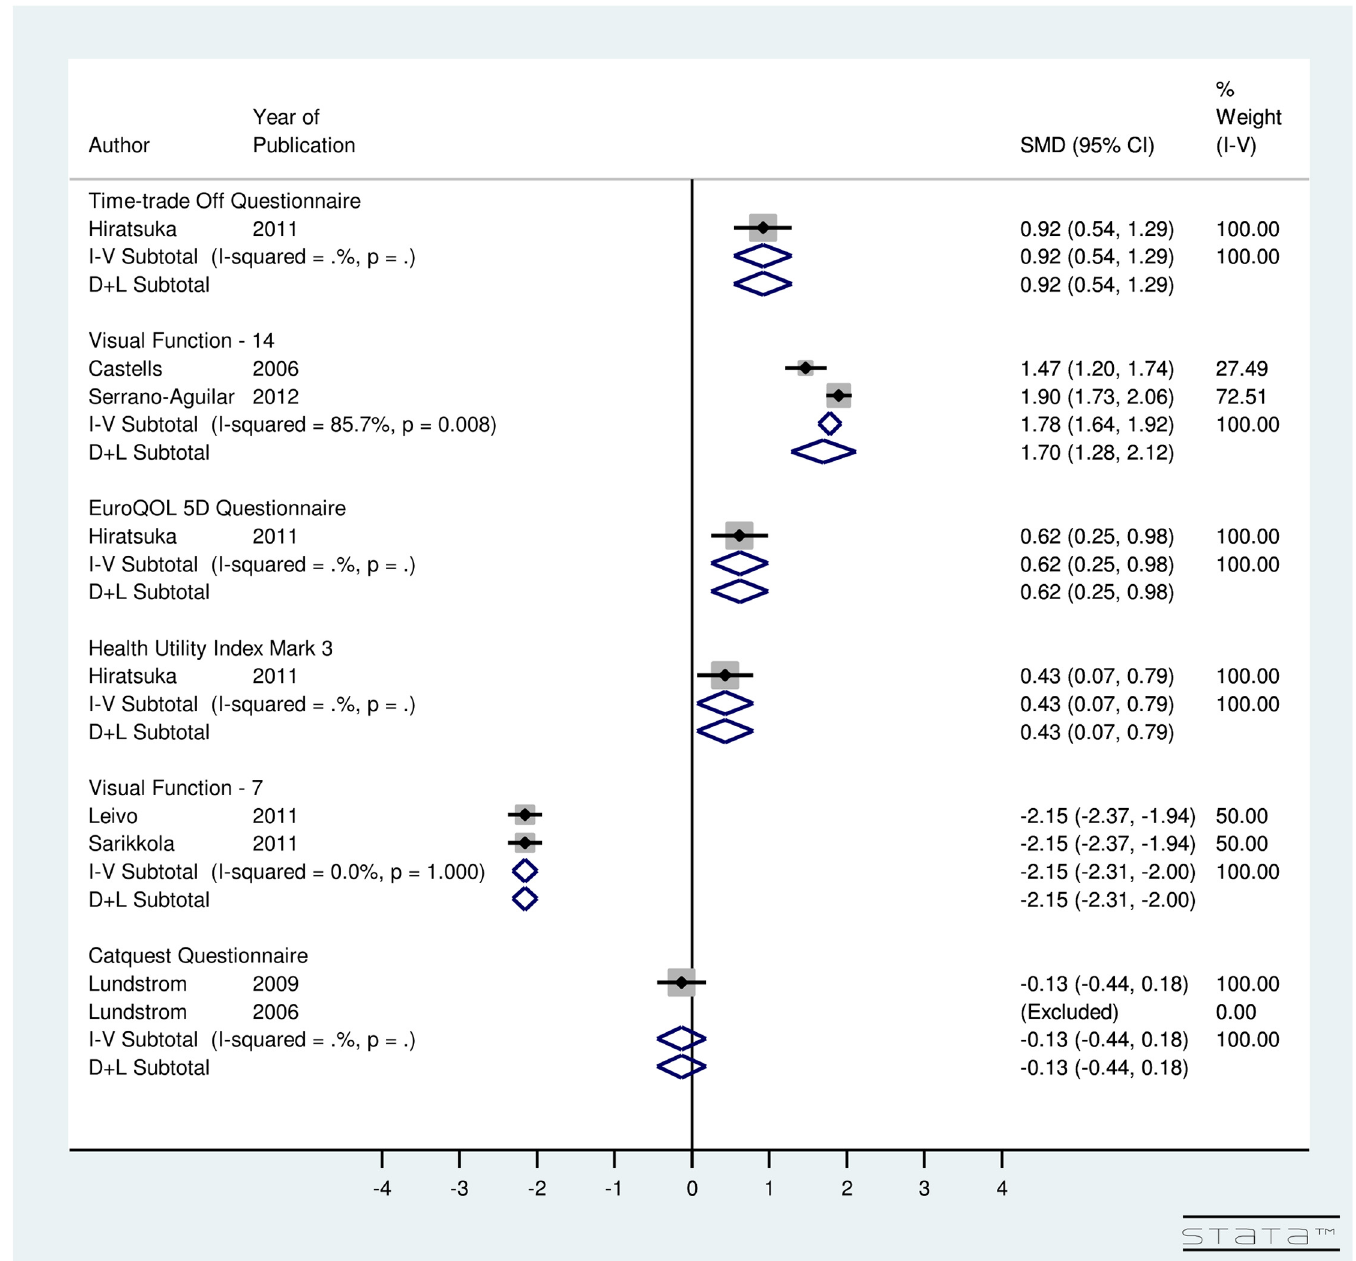
Fig 4. Forest Plot showing Improvement in Utility Due to Delayed Sequential Bilateral Cataract